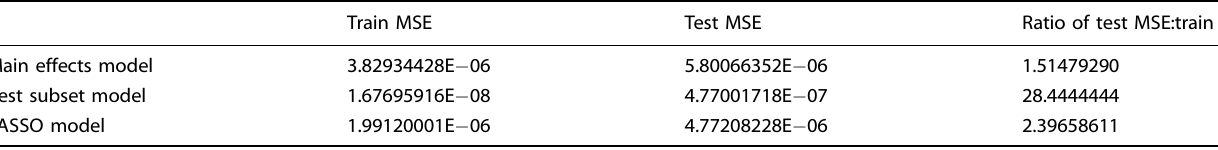
Table 4. Cross-validation error for the models. Train MSE Test MSE Ratio of test MSE:train MSE